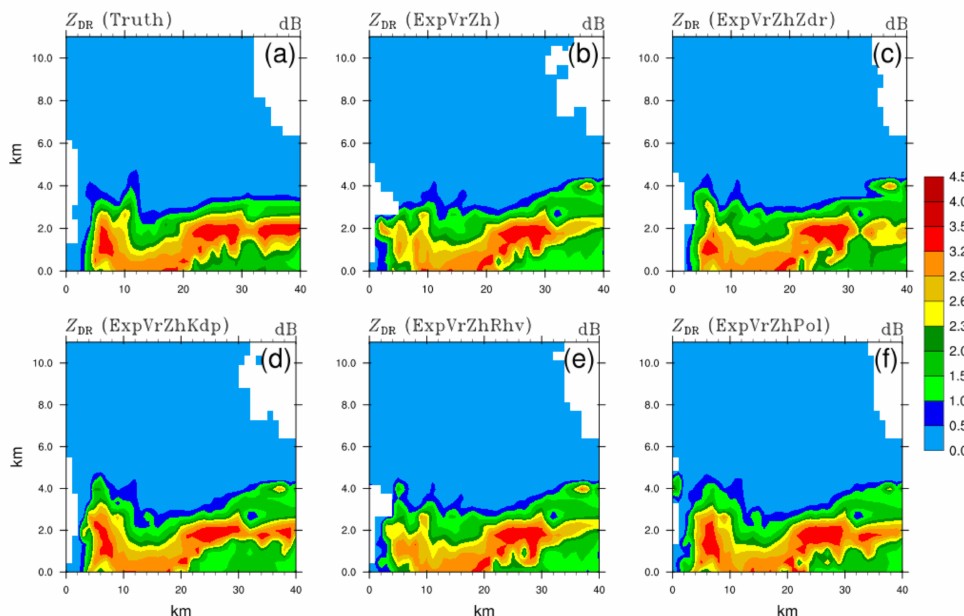
Figure 8. The same as Figure 7, but for the differential reflectivity Z DR of ( a ) truth, and analysis fields of ( b ) ExpVrZh, ( c ) ExpVrZhZdr, ( d ) ExpVrZhKdp, ( e ) ExpVrZhRhv, and ( f ) ExpVrZhPol,